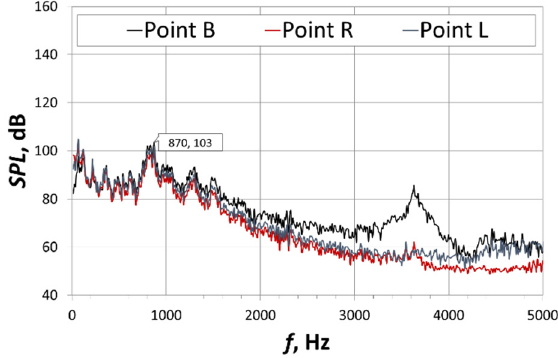
Figure 7. Spectral analysis of SPL for velocity equal to 30 m/s—CFD.